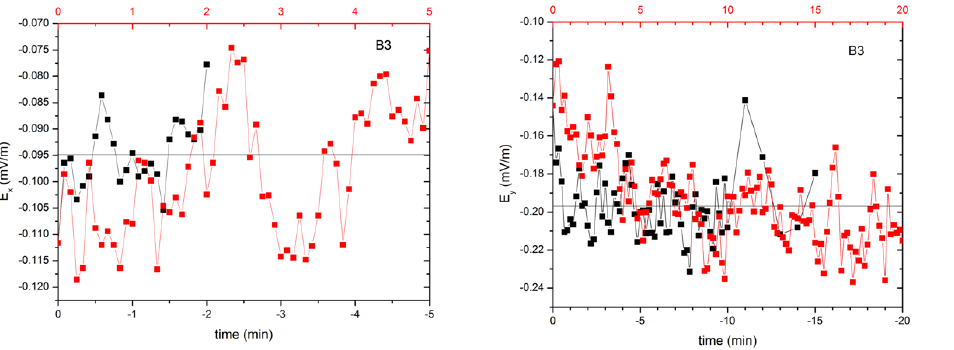
and E (in mV/m), observed along the AB and AC dipoles, respectively, related to the shot in Figure 3. Natural electric field components, E x y B3. Black symbols are used for data measured before the shot, while red symbols are used for data registered after the shot. The zero time of both the black and red scales corresponds to the shot time. The black continuous line represents the average value of the field compo- nent before the